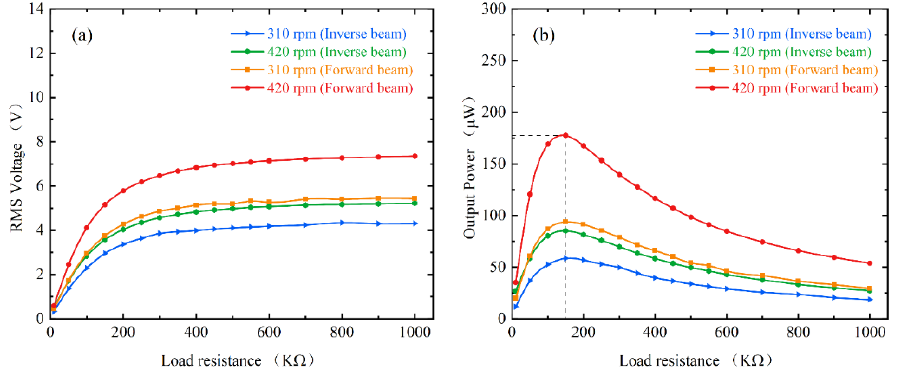
Figure 11. Experimental results of energy harvester under different load resistances: ( a ) RMS output